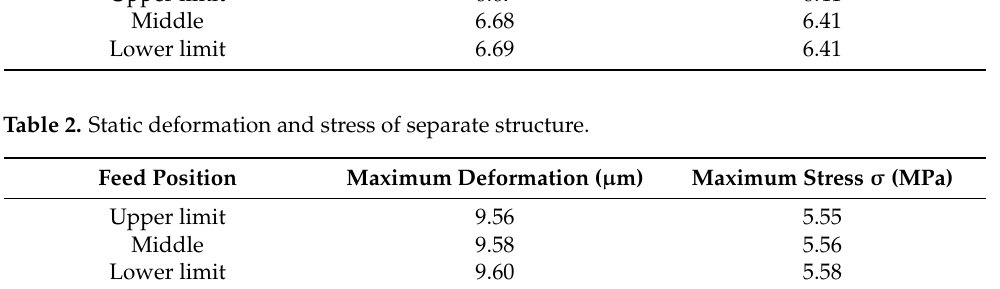
Figure 10. Equivalent load distribution on the connecting surface of the guide rail pair. ( a ) Integral structure ( b ) Separate structure. It can be seen that the maximum stress and maximum deformation of the integral structure both occur at the upper front end of the column, and the maximum deformation of the separate structure also occurs at this position, but the maximum stress point occurs at the bolt directly behind the column. The maximum deformation of the integral bed structure is 6.69 μm (Figure 11), which is about 30.3% less than that of the separate bed